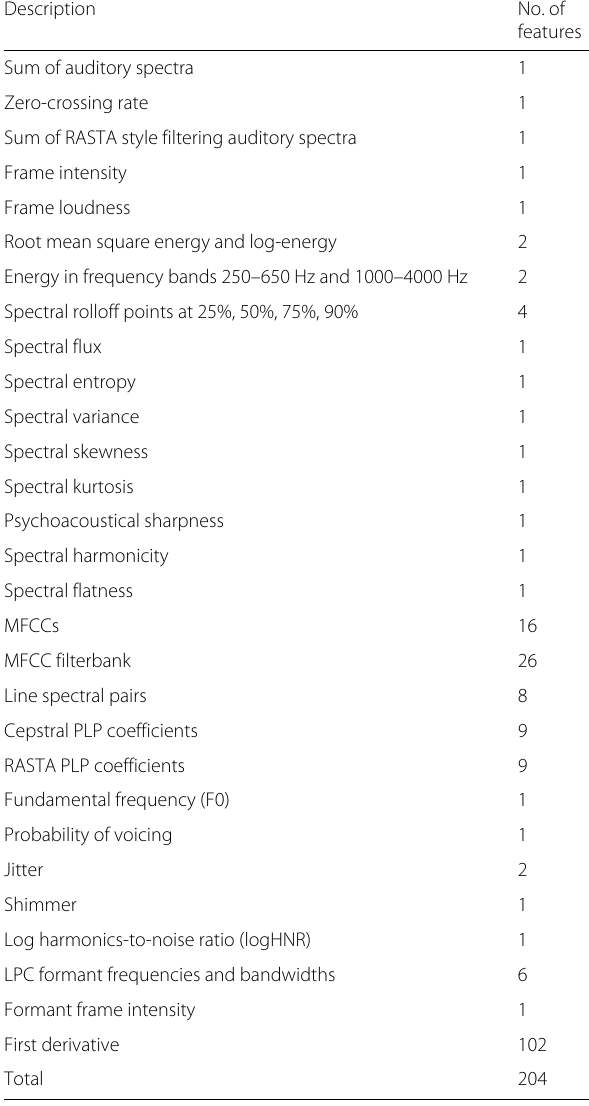
Table 6 Acoustic features used in the A-GTM-UVigo-Three feature+DTW-based fusion